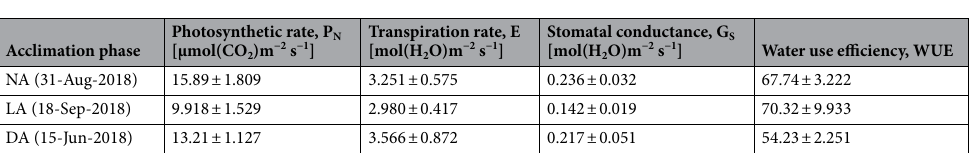
Table 2. Variability in leaf gas exchange parameters of R. anthopogon during the different acclimation phases (NA = Non-acclimation, LA = Late cold acclimation and DA = De-acclimation). Values are reported as mean ± standard